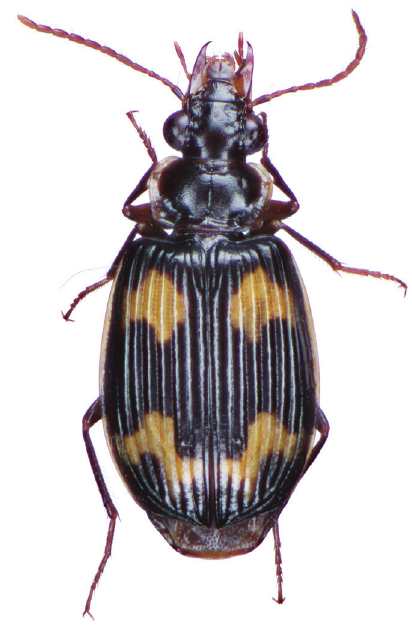
Figure 49. Dorsal habitus and color pattern of C. ( Coptoderina ) occulta sp. n.. (OBL 8.24 mm).